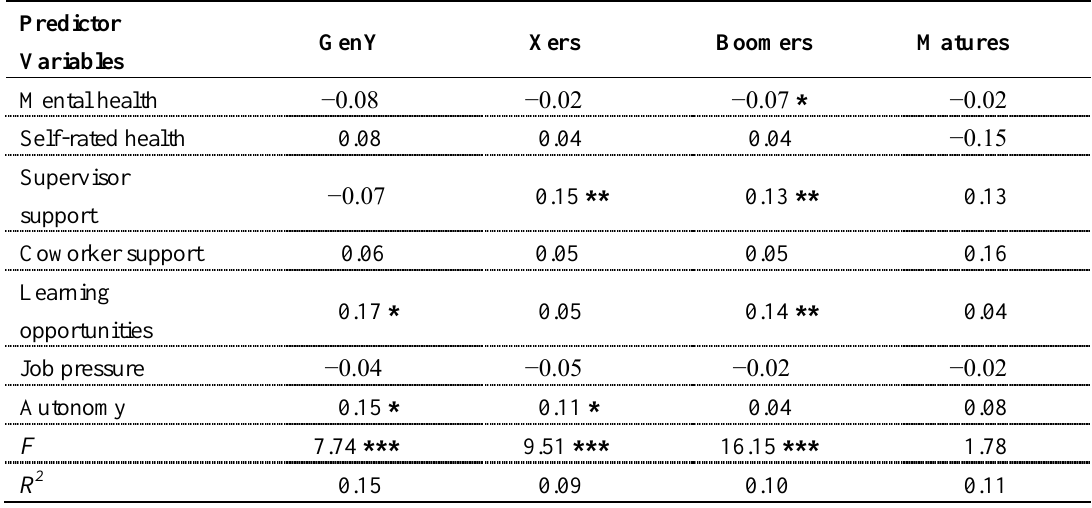
Table 5. Regressions of work-family synergy (WFS) on predictor variables by generational group.